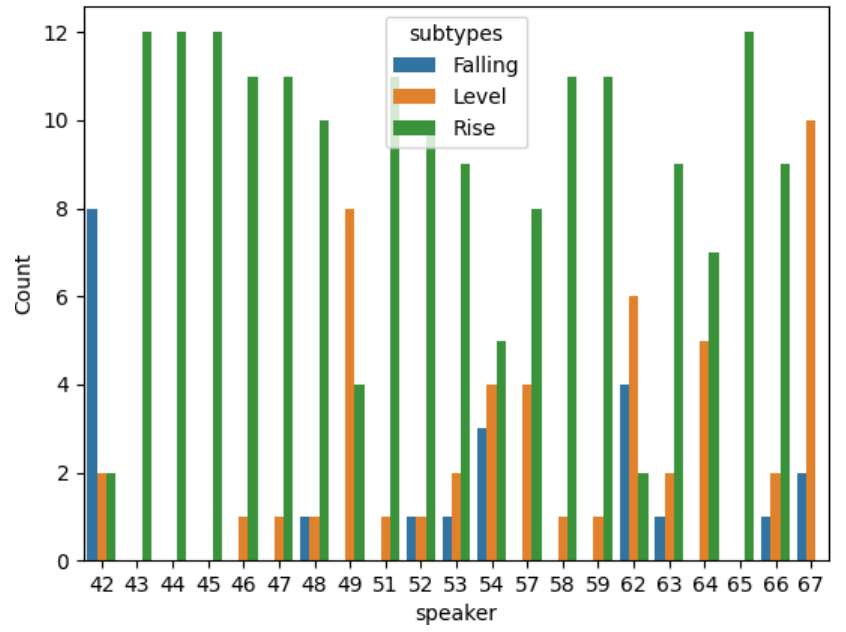
Figure 6. Variation of contour types according to